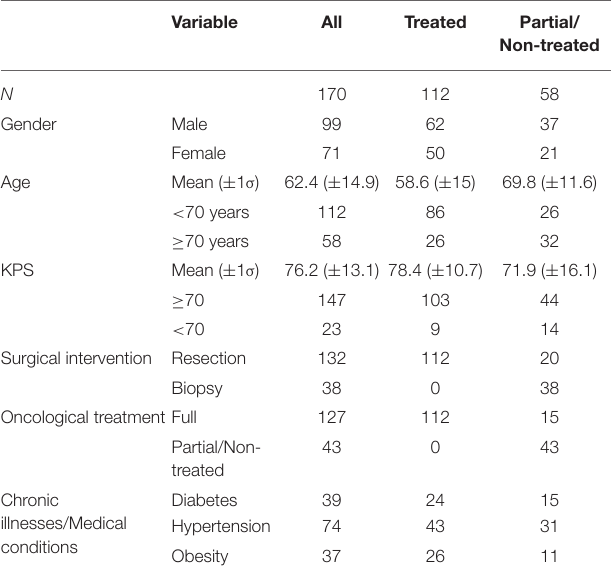
Theentirecohortwasdividedintothetreatedgroupwhichincludespatientswhosetumor